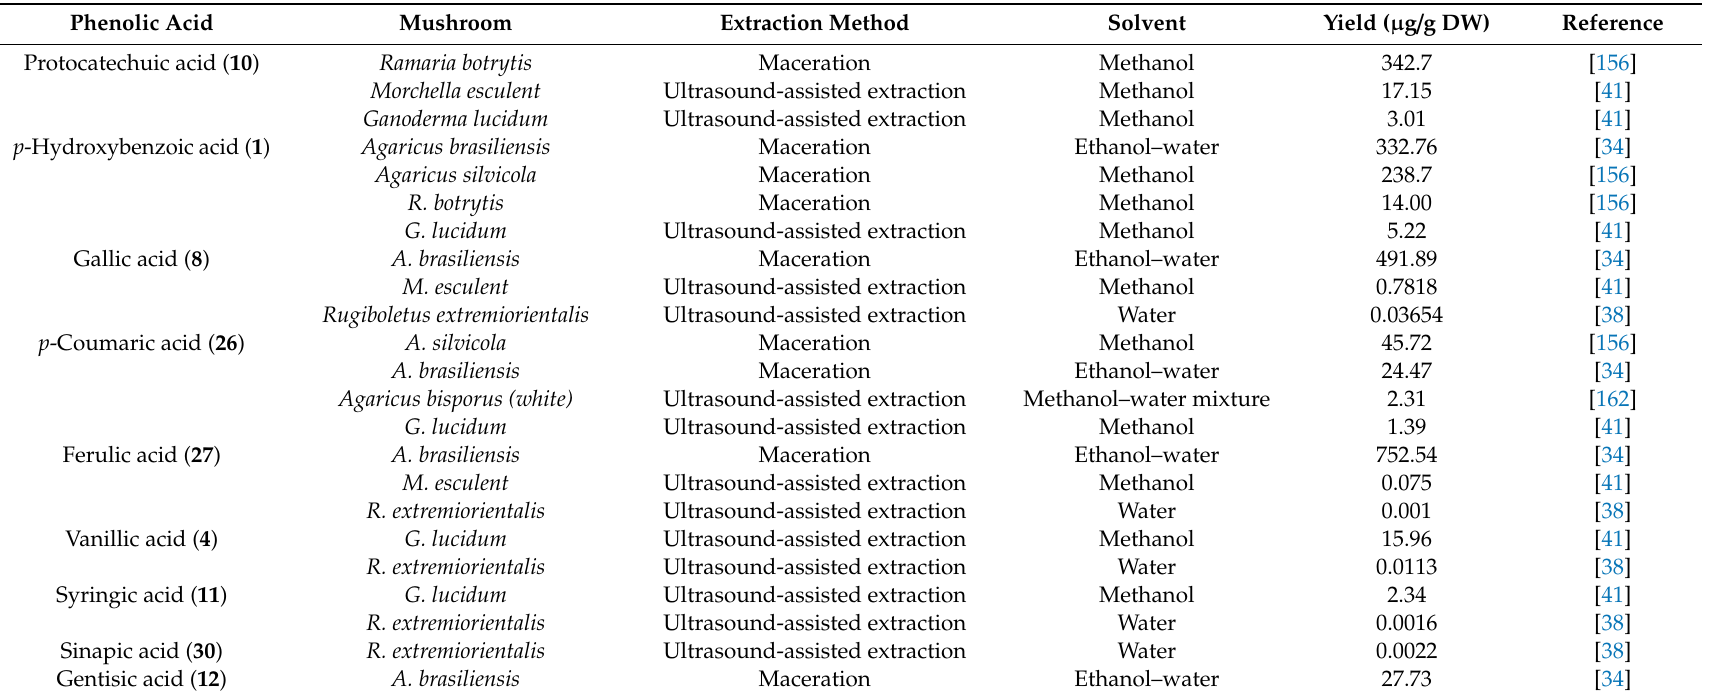
Table 4. Phenolic acid distribution in various species of